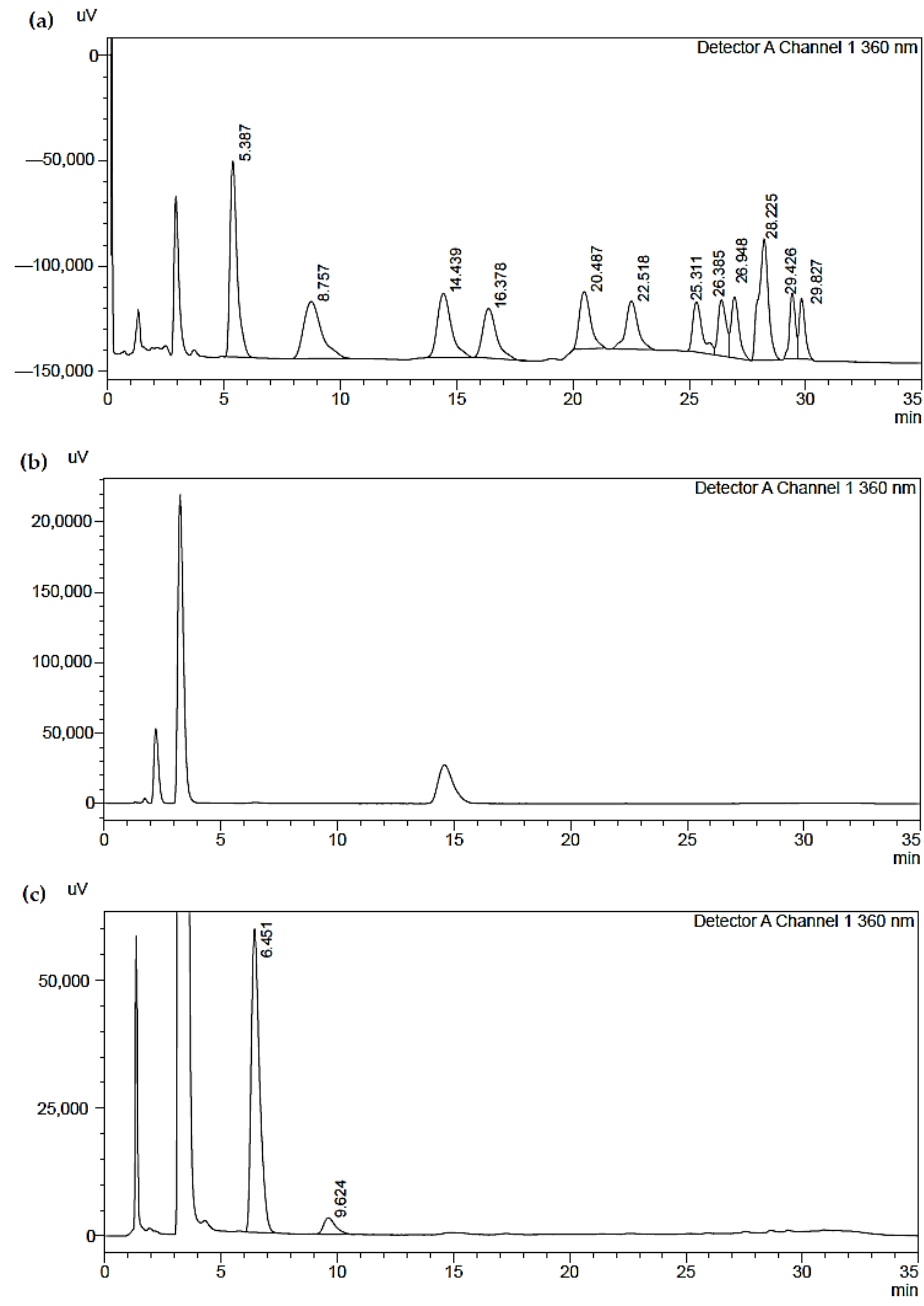
Figure 4. ( a ) Chromatogram of a reference standard used; ( b ) Chromatogram of a blank sample; ( c ) Chromatogram of a blank sample of one of the analyzed samples. Table 8. Peak table of the reference standard.